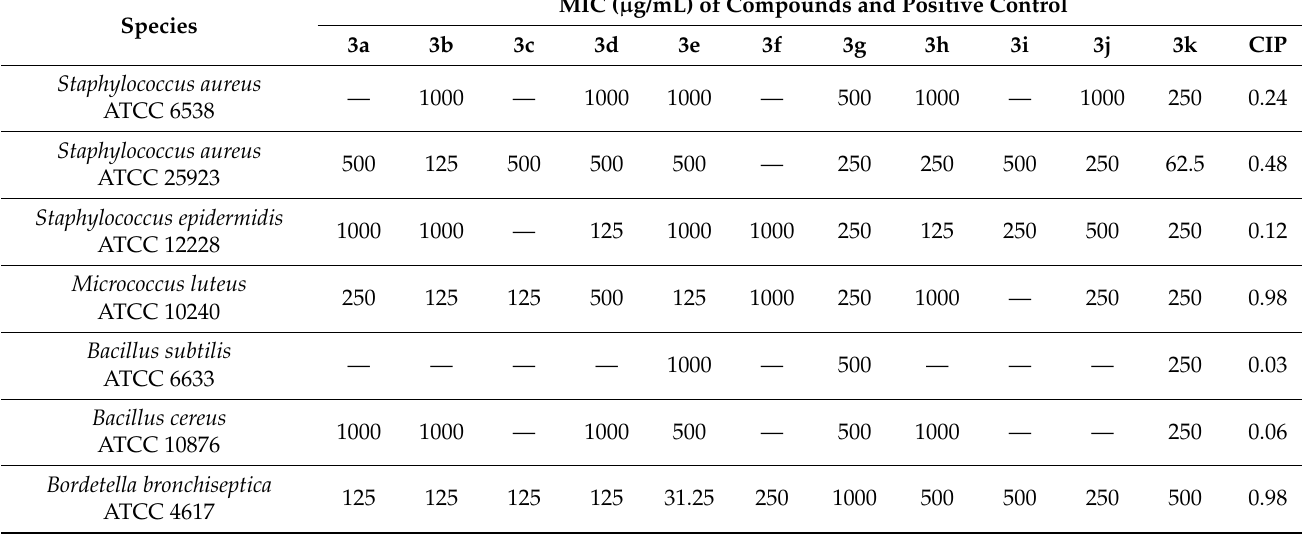
Table 1. The activity data of compounds expressed as MIC against the reference strains of bacteria. The standard antibiotic— ciprofloxacin (CIP) was used as positive